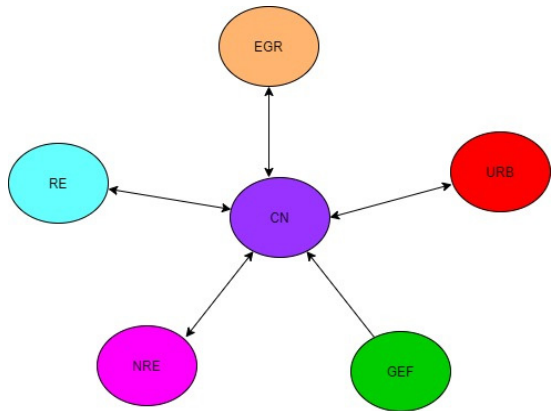
Figure 3. Causalities for the 10 selected MICs in the MENA Region.